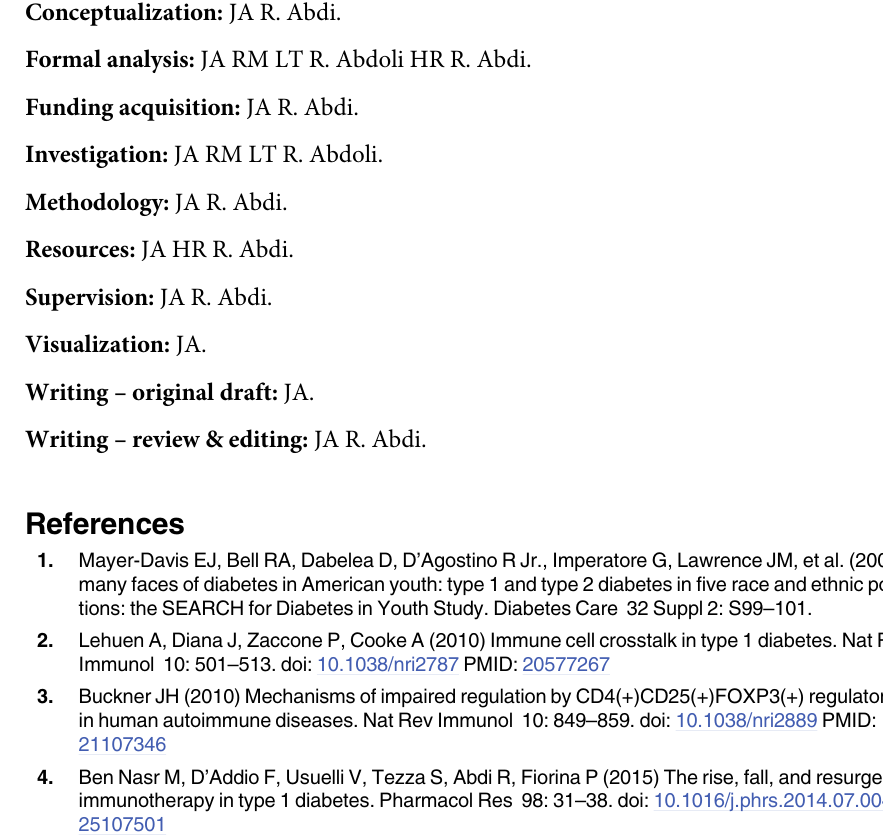
S1 Table. List and location of known insulin-dependent diabetes (Idd) genes compared to the PI3K γ gene. This table shows our search of the location of 26 known Idd genes in addition to the PI3K γ gene (chromosome 12 at 12;12B). The PI3K γ gene is not near any known Idd genes. This eliminates the possibility that the knockdown of the PI3K γ gene might affect an adjacent IDD gene, known to control the development of autoimmune-diabetes in both humans and NOD-mice. (PDF) S1 File. Marker-Assisted Accelerated Backcrossing supporting information. A. Description of the Marker-Assisted Accelerated Backcrossing technology used to generate the new NOD. PI3K γ -/- mouse. B. Data from the Marker-Assisted-Accelerated-Backcrossing-program at Charles-River Laboratory that shows the scan of a panel of 384 single-nucleotide-polymor- phisms (SNP) throughout of the genome of NOD.PI3K γ -/- mouse.